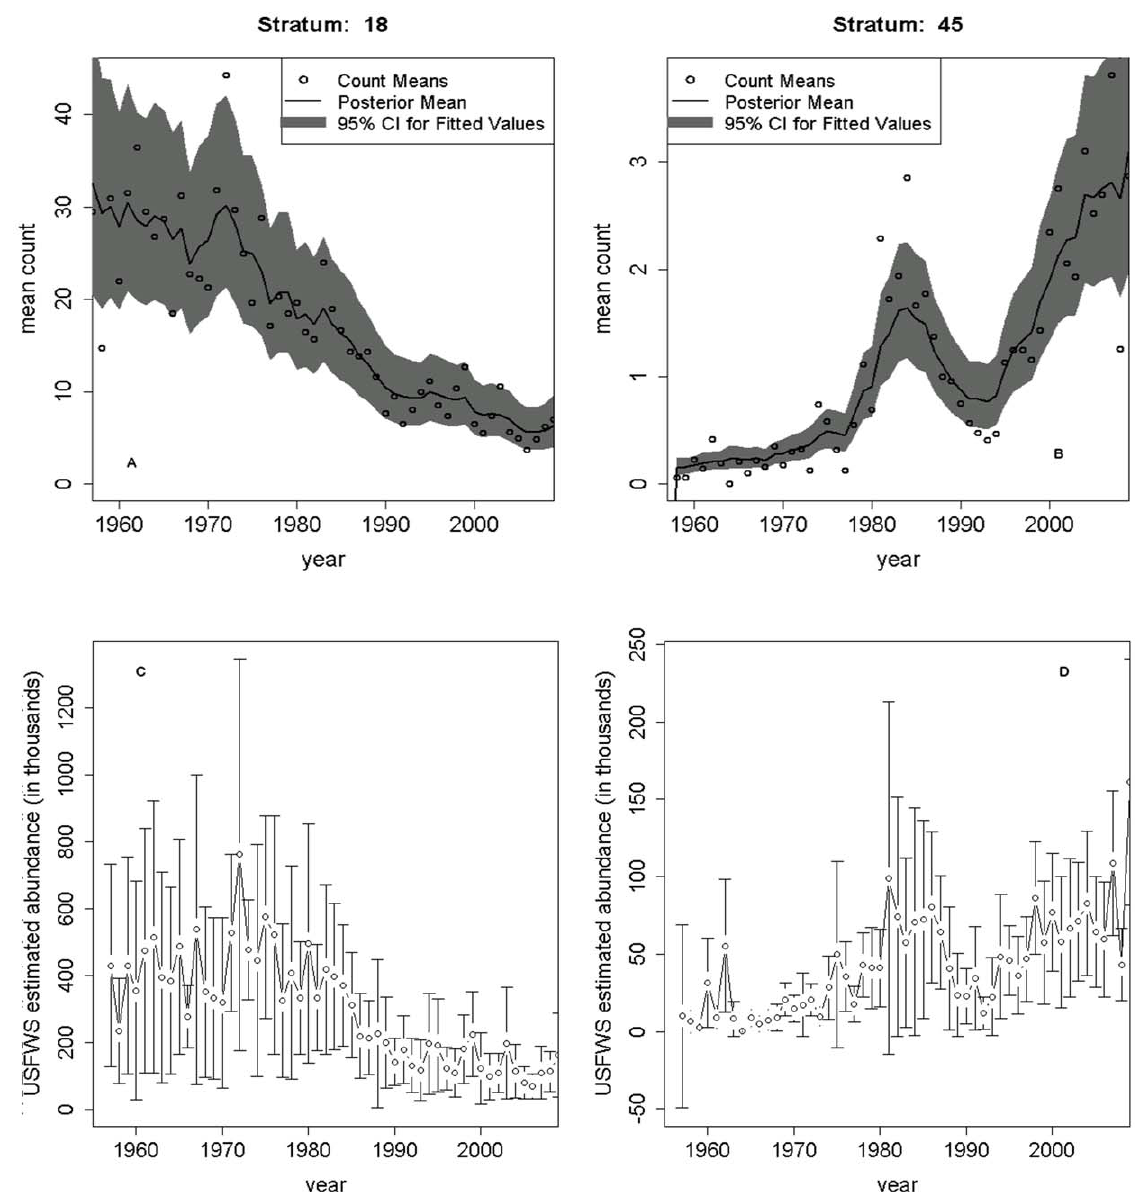
Figure 4. Marginal posterior predictive distributions from Strata 18 (A) and 45 (B) from the zero-inflated negative binomial model, and estimates of total scaup abundance from USFWS (C and D). Estimates from USFWS are calculated using counts of all scaup from aerial surveys adjusted by a visibility correction factor. inflated negative binomial model with random spatio-temporal effects.